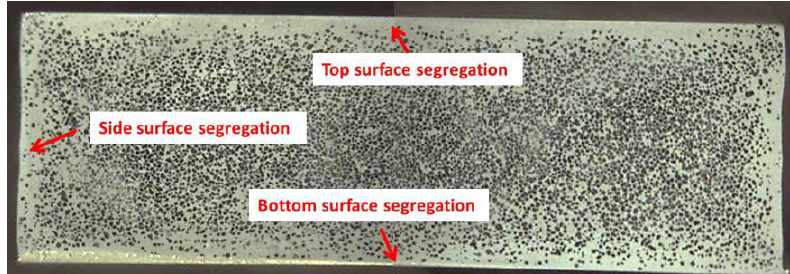
Figure 9. Distribution of primary α -Mg in entire cross-section of the sample.